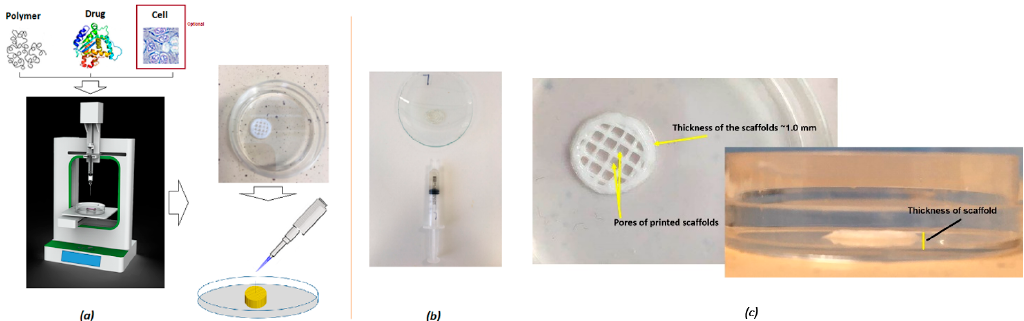
Figure 1. Schematic diagram of ( a ) the optimized 3D bioprinting process, ( b ) the extrudable bioink, and ( c ) the printed scaffold with 3D texture.